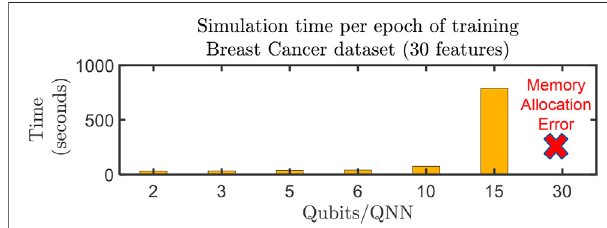
FIGURE 12 | QNet models are suitable for simulation based QML applications where quantum simulators are used for training and inference of QNN models for practical applications. We report the time taken for 1 training epoch on the Breast Cancer classi fi cation dataset with varying QQ. This dataset contains 569 samples (30 features) and we use half of them (285) for training. The training is done on a standard desktop machine (Intel Core i7- 10750H,16 GBRAM)usingasinglecomputingcore.Weusethedefaultstate vector simulator available in the PennyLane framework. With lower QQ, the model can be trained in minutes. With higher QQ, the training time increases due to larger memory requirements by the simulator.